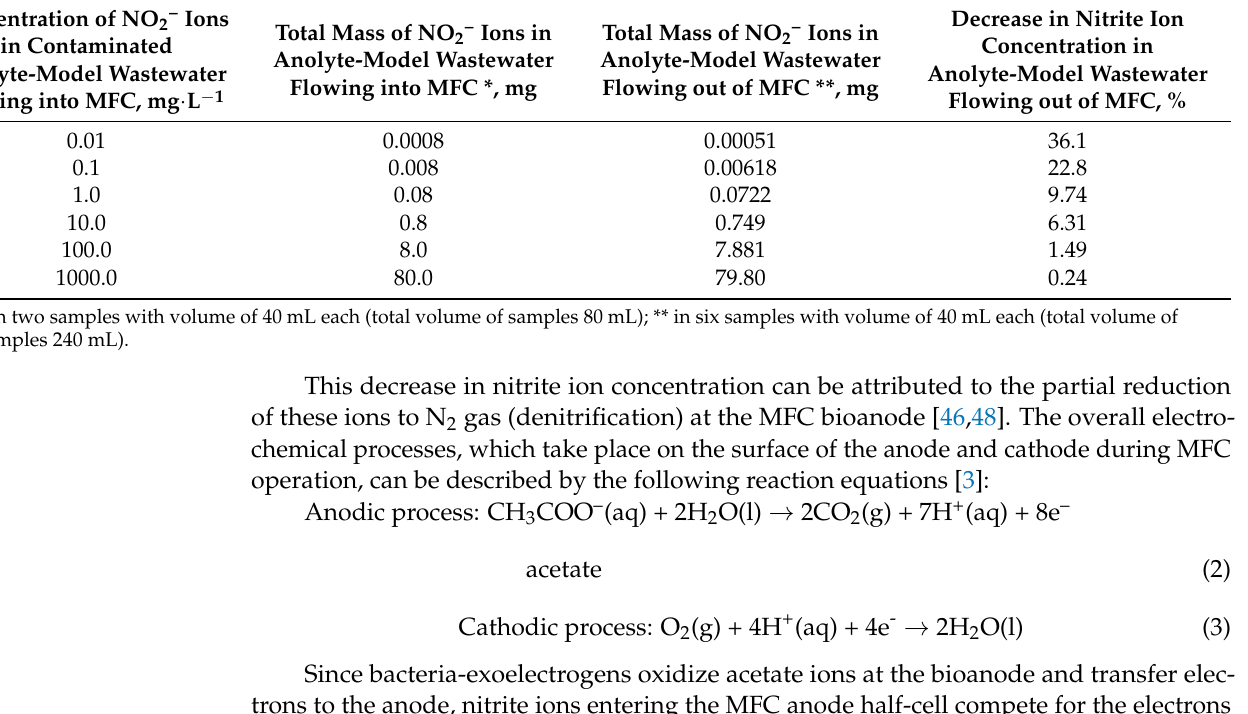
Table 2. Concentration and total mass of NO 2– ions in nitrite ion-contaminated anolyte-model wastewater at the inlet and outlet of the microbial fuel cell (MFC) anode